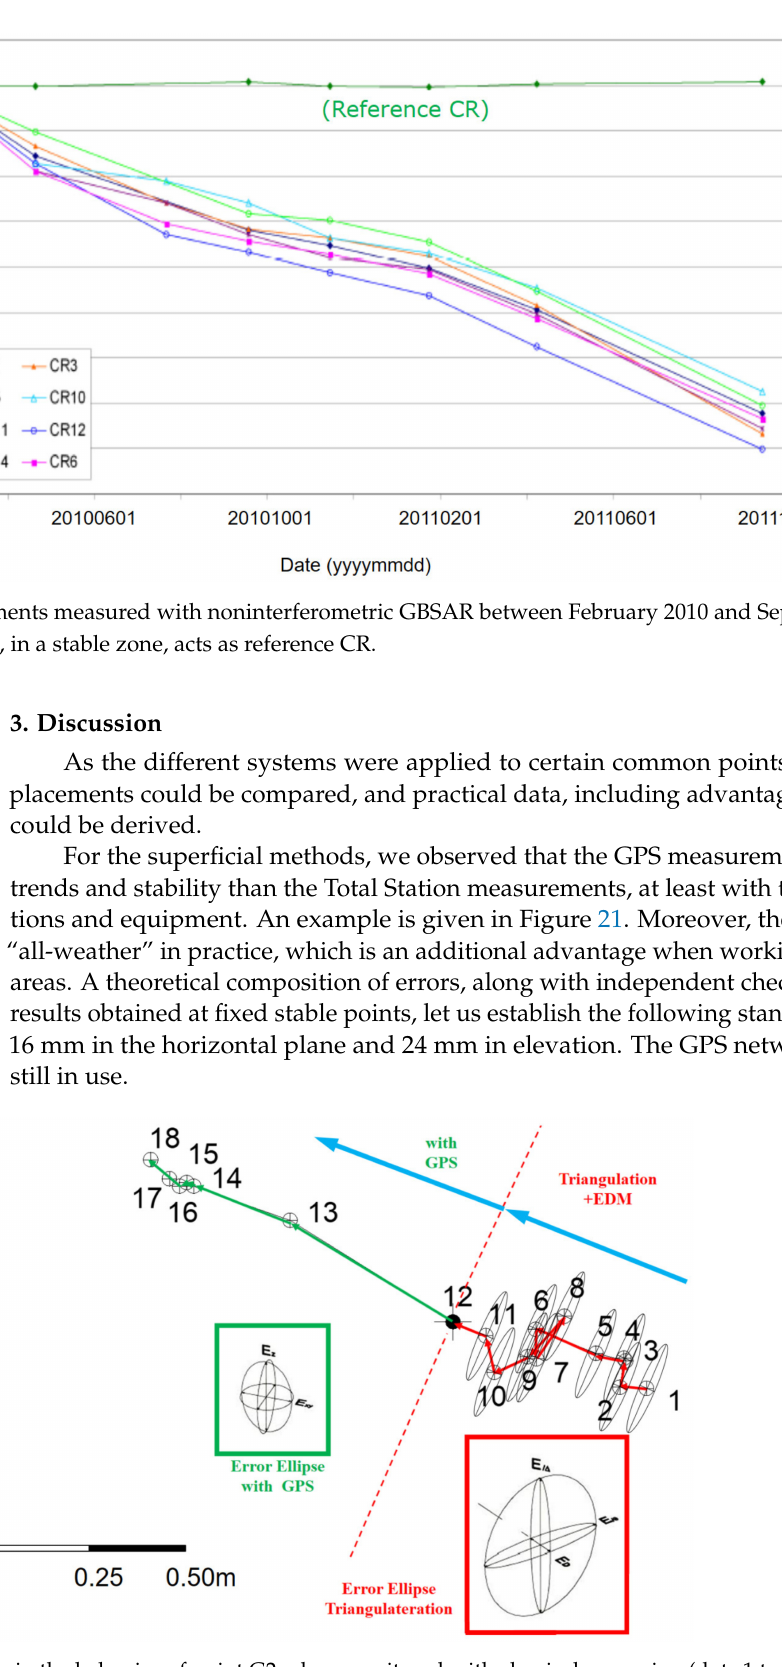
Figure 21. Apparent change in the behavior of point G2 when monitored with classical surveying (dots 1 to 12) or with GPS (dots 12 to 18). The insets with the error ellipses for both systems show a more balanced and better precision for the GPS measurements. Blue arrow points towards the Total